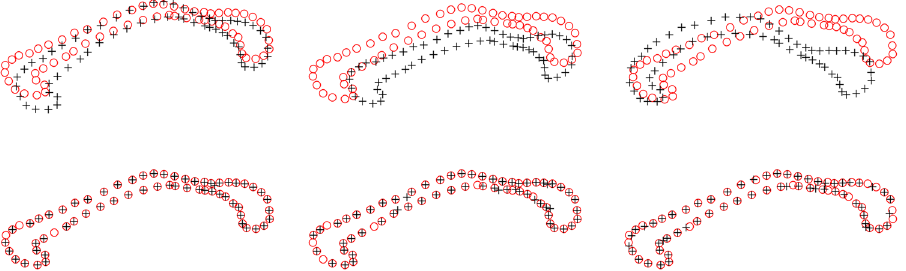
Figure 2. Performance of DSMM on 2D Corpus Callosum data. The target points are denoted as red “o” and the template points are denoted as black “ + ”. Each point set contains 63 points respectively. We align the black “ + ” to the red “o” by using DSMM. The point sets before registration is superimposed in the top row, and the performance of DSMM is shown in the bottom